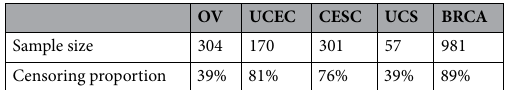
Table 2. Overview of the samples from the five Pan-Gyn cancer